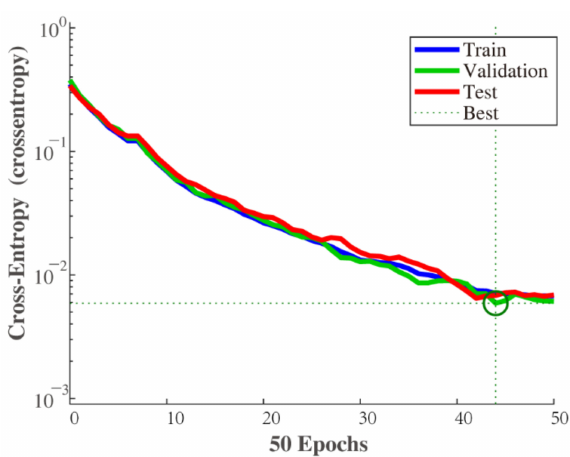
Figure 8. Features of samples.